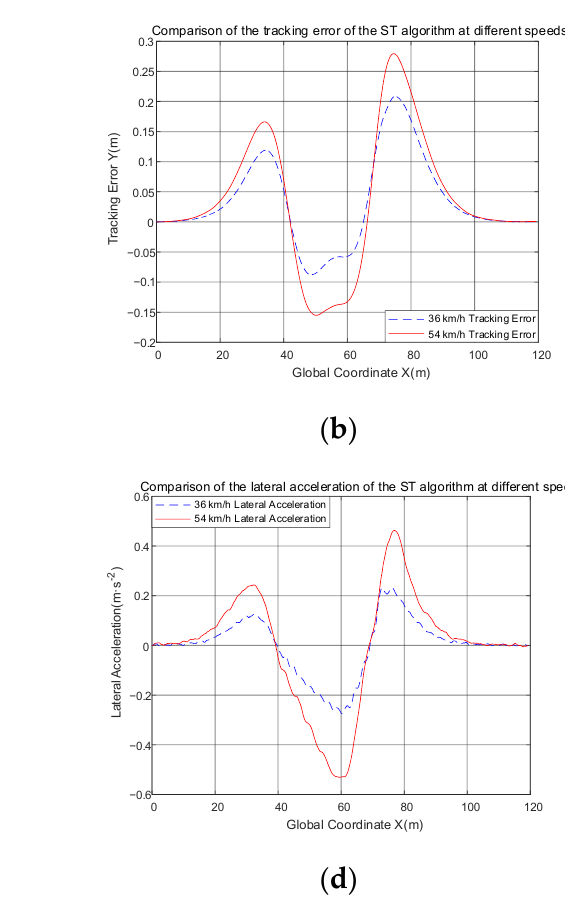
Figure 13. ( a ) Comparison of trajectories at different speeds; ( b ) comparison of tracking error at different speeds; ( c ) comparison of steering angle at different speeds; ( d ) comparison of lateral acceleration at different speeds.